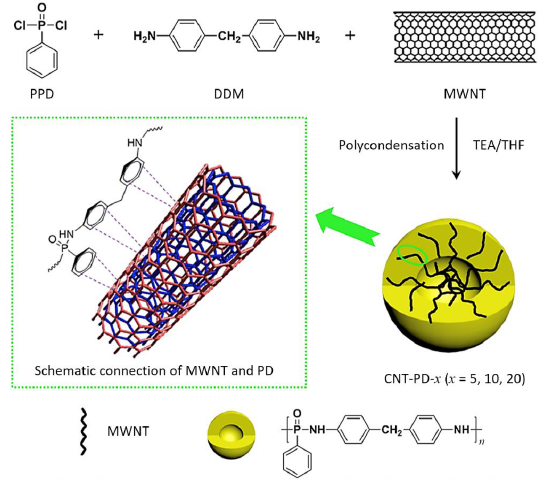
Figure 24. Schematic of the synthesis of MWNTs-PD- x . PD was wrapped in MWNTs by polycondensation. Reprinted with permission from Ref. [181]. Copyright 2016, Elsevier.